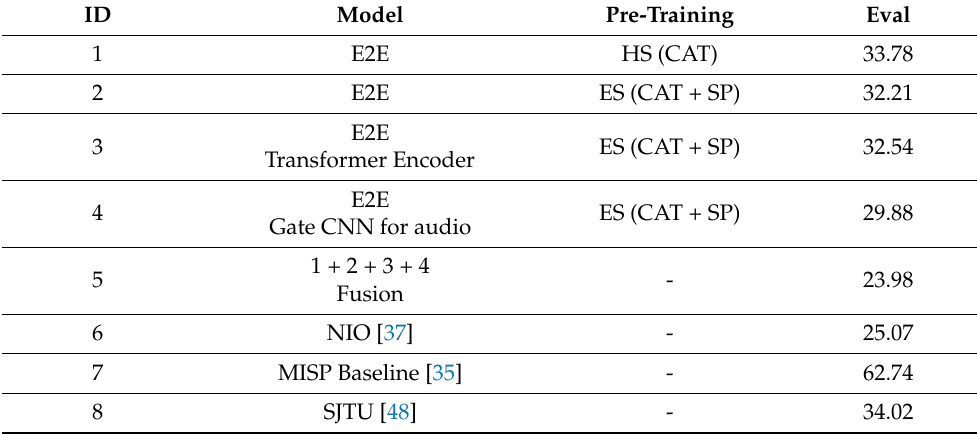
Table 7. The results (CER %) of system fusion. HS and ES mean the hybrid system and end-to-end system, respectively. M and N denote the number of blocks in the encoder and decoder modules, respectively. CAT means splicing the continuous segments. SP means speed